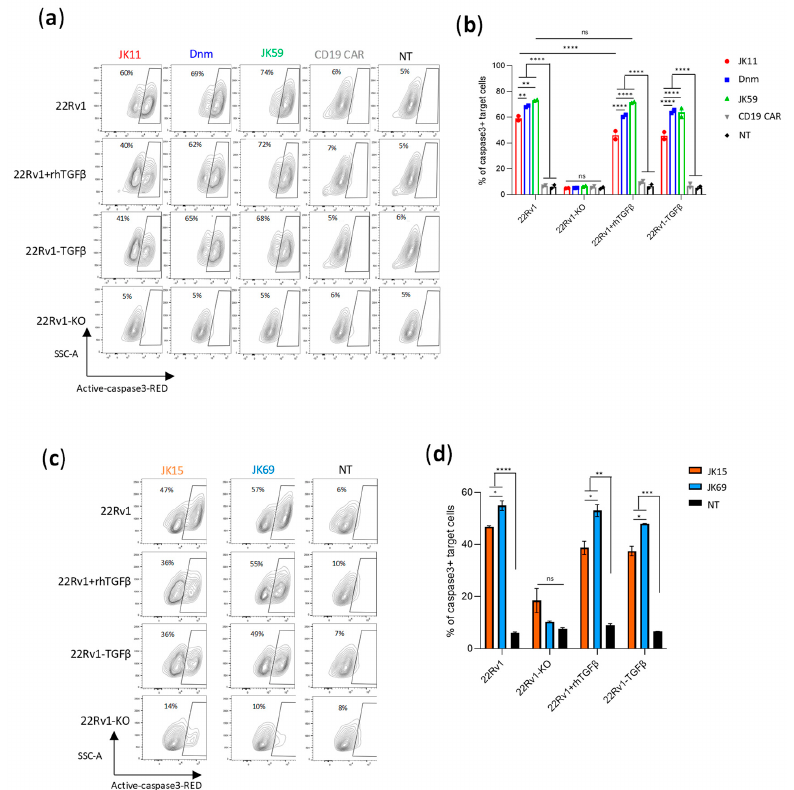
Figure 3. SwR-STEAP1 CAR T cells have superior cytotoxic activity in a TGF β -rich environment. ( a ) Representative contour plots of 22Rv1, 22Rv1-KO, and 22Rv1-TGF β target cell lines, and 22Rv1 target cells in the presence of 10 ng/mL rhTGF β , co-cultured with freeze-thawed and non-activated JK11, Dnm, JK59, and CD19 CAR T cells, or NT T cells, at an E:T ratio of 1:1 for 48 h. Lysis of target cells was measured by the intensity of Red-active-caspase3, using flow cytometry. ( b ) A graph representing the percentage of apoptotic cells among 22Rv1, 22Rv1-KO, and 22Rv1-TGF β cell lines and 22Rv1 cells cultured in the presence of 10 ng/mL rhTGF β . Data represent the mean values ± SEM of two healthy donors from one representative experiment, in which each co-culture was performed in duplicate. The experiment was repeated two times. Data were analyzed by two-way ANOVA with Tukey’s multiple comparisons test. ** p < 0.01; **** p < 0.0001; ns = not significant. ( c ) Representative contour plots of 22Rv1, 22Rv1-KO, 22Rv1-TGF β target cell lines, and 22Rv1 target cells in the presence of 10 ng/mL rhTGF β , co-cultured with frozen/thawed and non-activated JK15 and JK69 CAR T cells, or non-transduced (NT) T cells, at an E:T ratio of 1:1 for 48 h. Lysis of target cells was measured by the intensity of Red-active-caspase3 staining/labeling by flow cytometry (gating strategy in Figure S4d). ( d ) A graph representing the percentage of apoptotic cells among 22Rv1, 22Rv1-KO, 22Rv1-TGF β cell lines, and 22Rv1 cells cultured in the presence of 10 ng/mL rhTGF β . Data represent the mean values ± SEM of one healthy donor (in duplicates) from one representative experiment. The experiment was repeated two times. Data were analyzed by one-way ANOVA with Tukey’s multiple comparisons test. * p < 0.05; ** p < 0.01; *** p < 0.001; **** p < 0.0001; ns = not